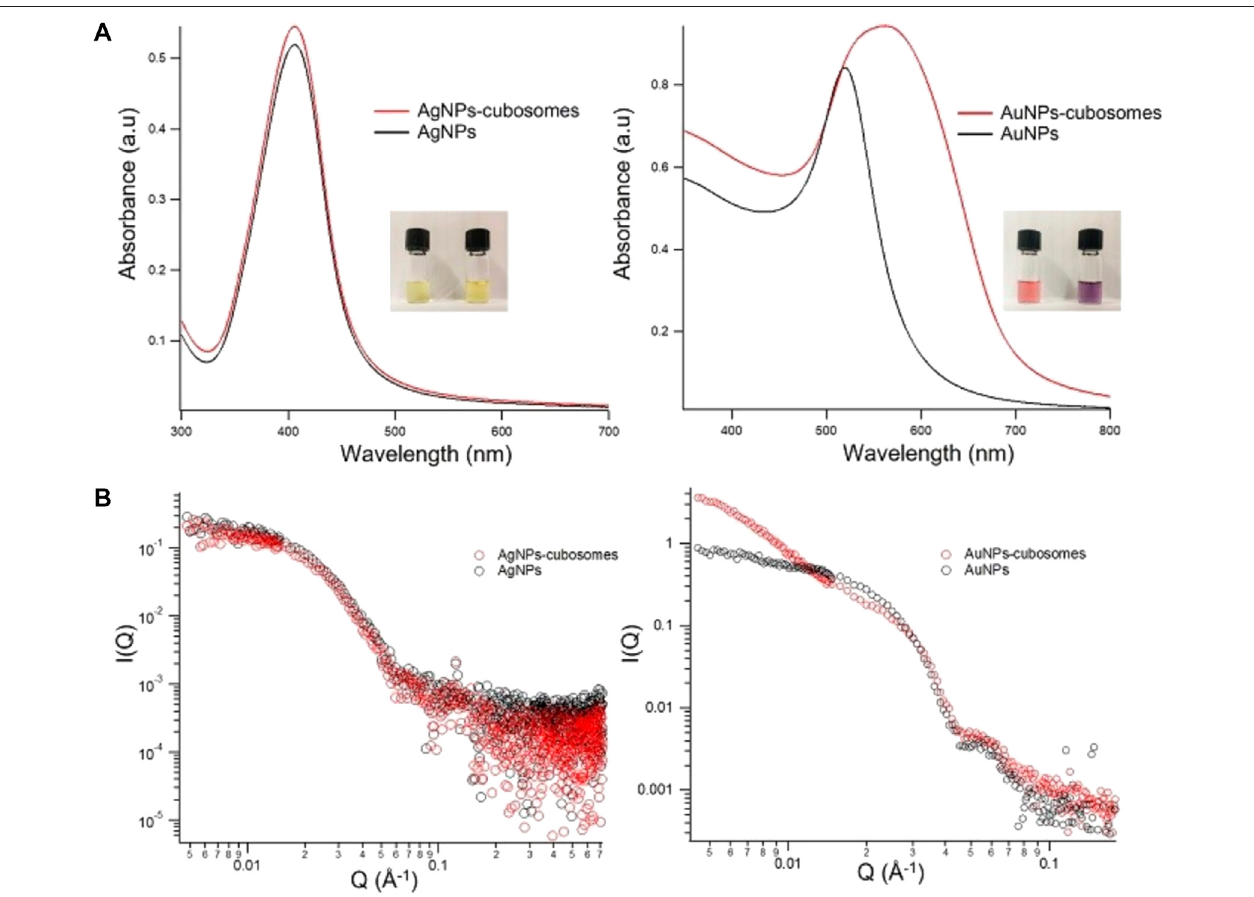
FIGURE 2 | (A) : UV-Visible absorption pro fi les of AgNPs-cubosomes (left) and AuNPs-cubosomes (right). (B) : Log-log SAXS pro fi les of AgNPs-cubosomes (left) and AuNPs-cubosomes (right) hybrids. 300 µL of NPs (8.3 × 10 − 10 M) were mixed with 20 µL of 0.4 mg/ml cubosomes (for a fi nal concentration of cubosomes in the mixture of 0.025 mg/ml) and SAXS and UV-vis pro fi les were collected after 10 min of incubation. The SAXS pro fi le of cubosomes in water at a 0.025 mg/ml lipid concentration has been subtracted from AgNPs-cubosomes and AuNPs-cubosomes pro fi les.